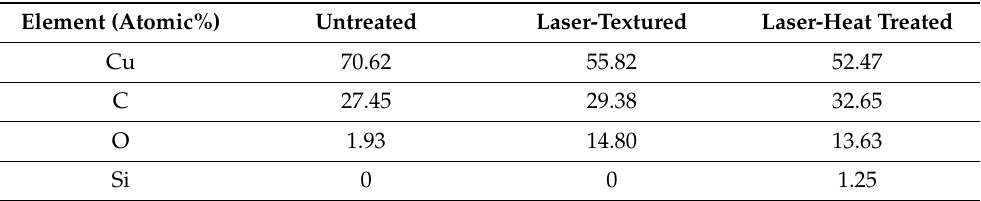
Table 2. Detailed atomic elemental compositions for untreated Cu foam, laser-textured Cu foam and laser-heat treated Cu